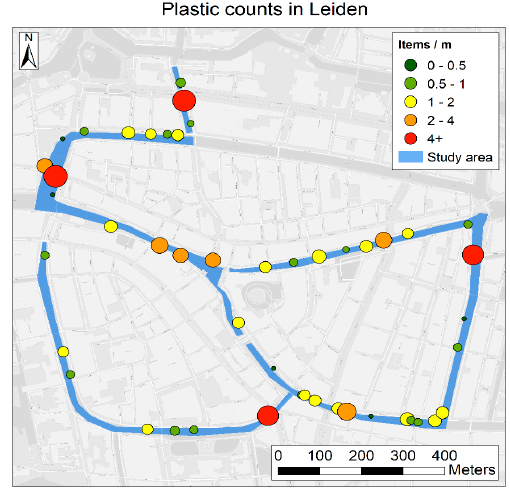
Figure 4. Plastic item density in the Leiden urban water system, 6 March 2020.